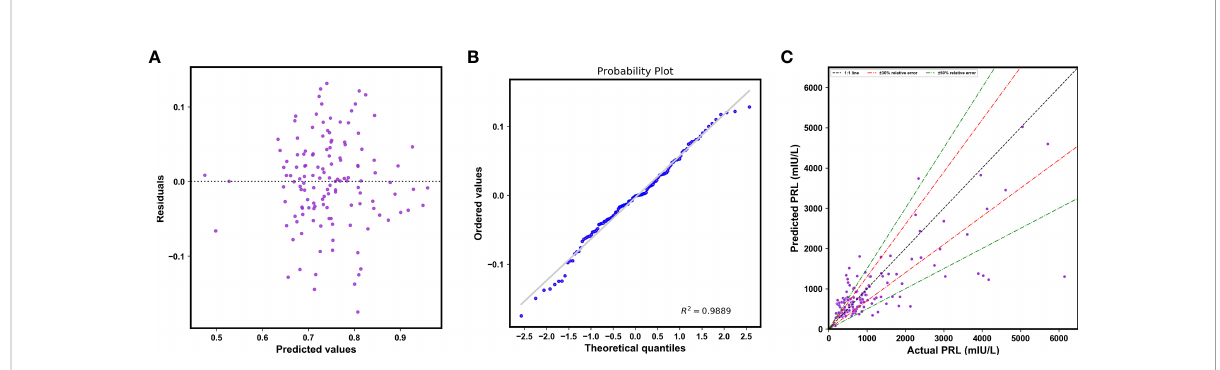
FIGURE 6 (A) Plot of residuals vs. the predicted log-transformed PRL values. (B) The normal plot of the residuals. (C) Scatterplot of the predicted PRL values vs. actual PRL